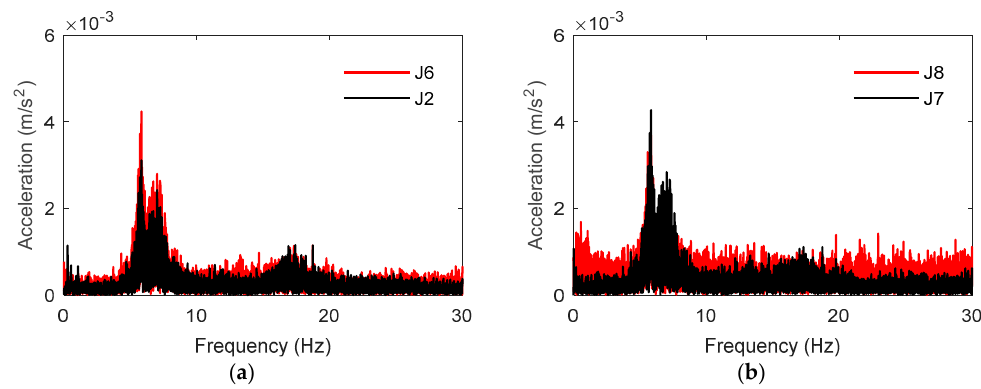
Figure 13. Frequency domain comparison of acceleration responses at various measurement positions in storm condition C2. ( a ) J2 and J6; ( b ) J7 and J8.